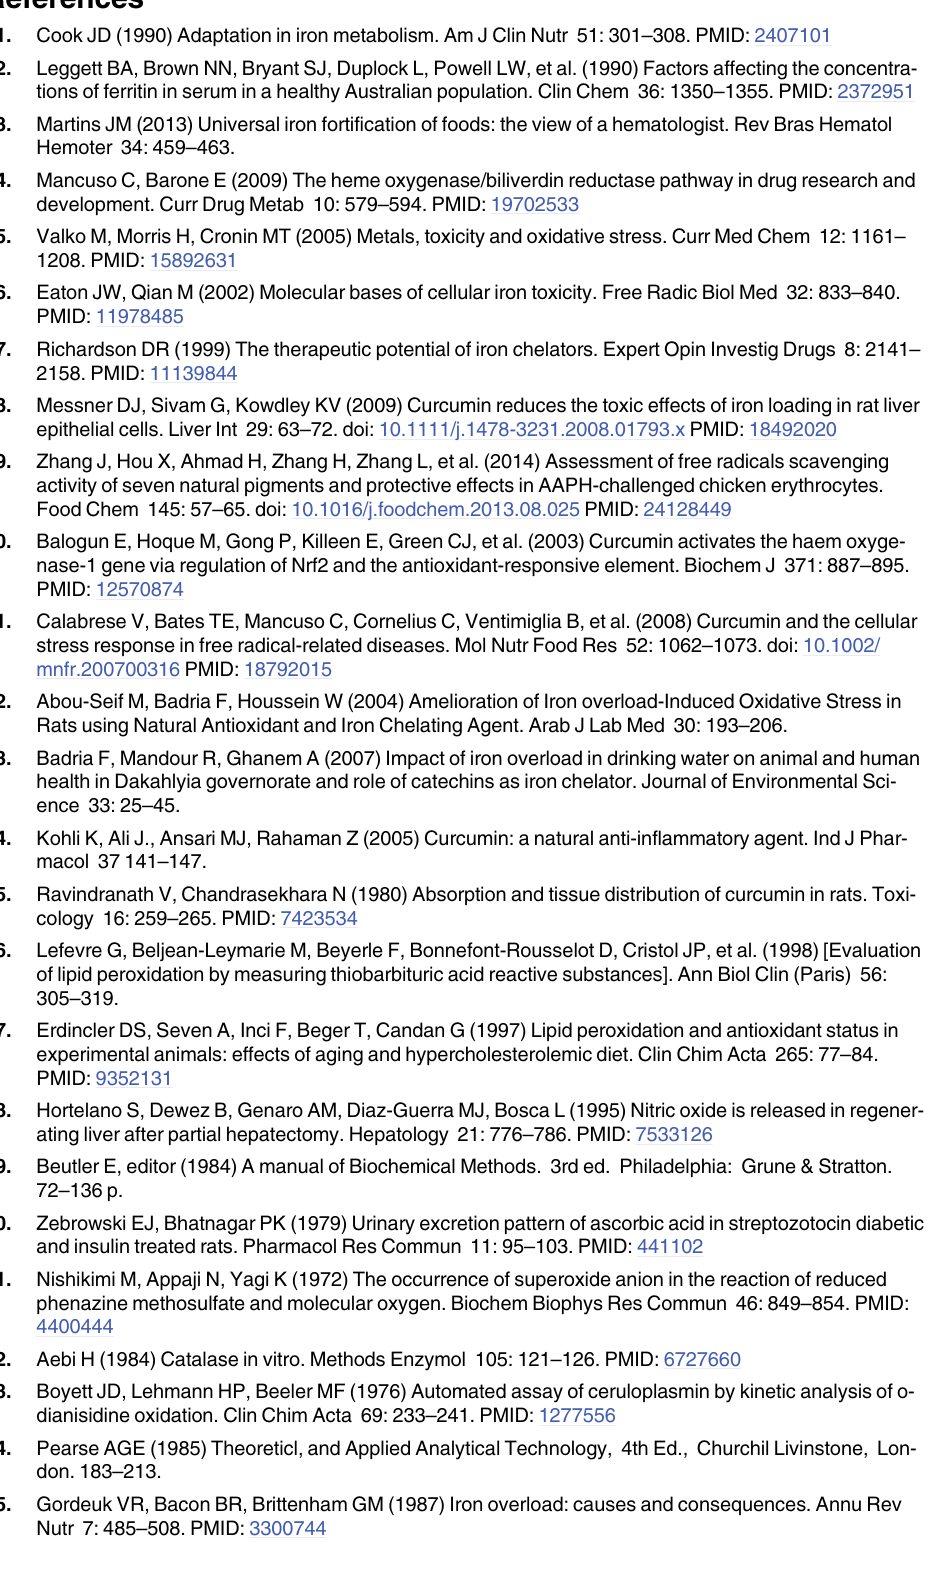
PLOS ONE | DOI:10.1371/journal.pone.0134156 July 31,